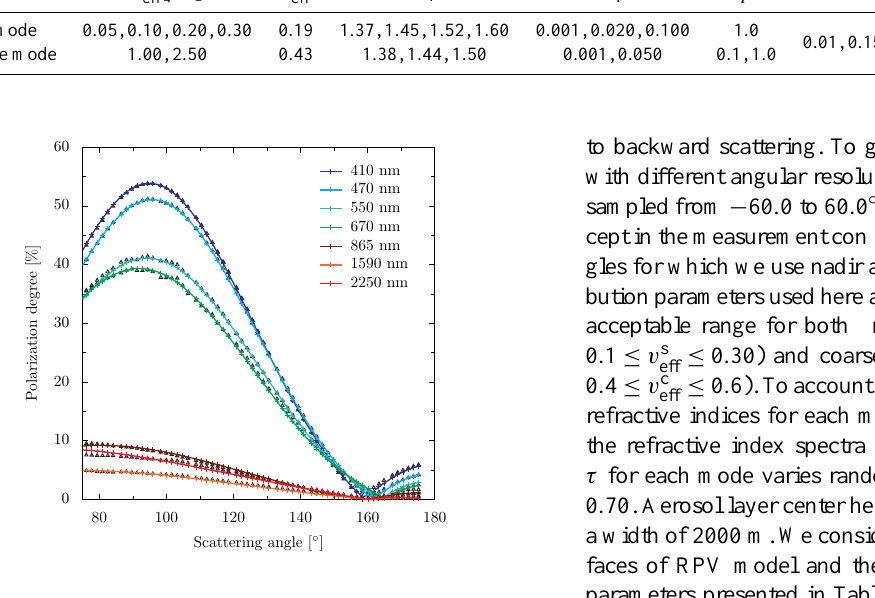
Figure 6. One example of RSP measurements and the correspond- ing fit results for DOLP in retrieval. Triangle symbols denote the RSP measurements and solid lines with plus are fits using the for- ward model in Sect. 3. The date, AERONET site (longitude, lat- itude), number of viewing angles, AOD, mean angular deviation from the principal plane and solar zenith angle are 9 September 2013, Baskin (91 . 73 ◦ W, 32 . 28 ◦ N), 60, 0 . 27 ( 440nm ) , 1 . 99 ◦ and 66 . 5 ◦ , respectively.